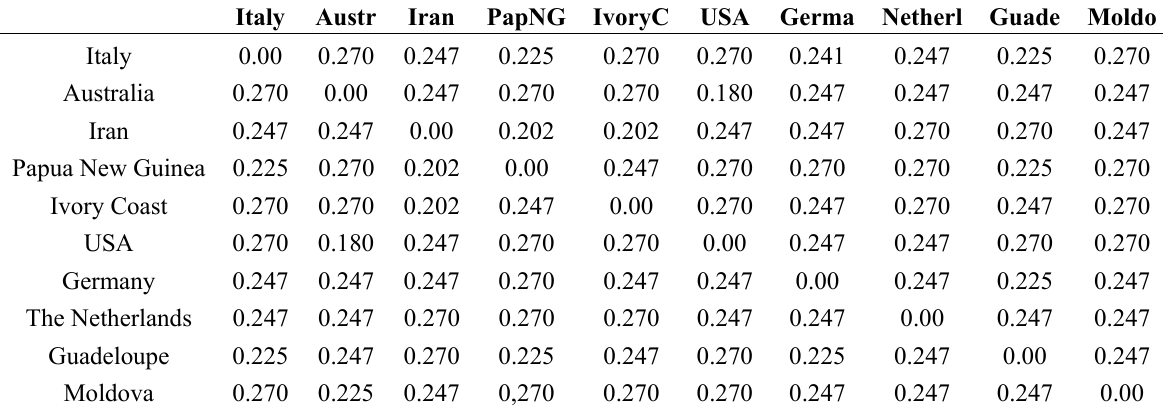
Table 3. Pairwise genetic distances matrix from the T. virens set of isolates. Range: 0.18–0.27, number of sequences: 12, active sites: 89, number of constant sites: 0, number of non-parsimony informative sites: 31, fit: 97.97, least squares fit: